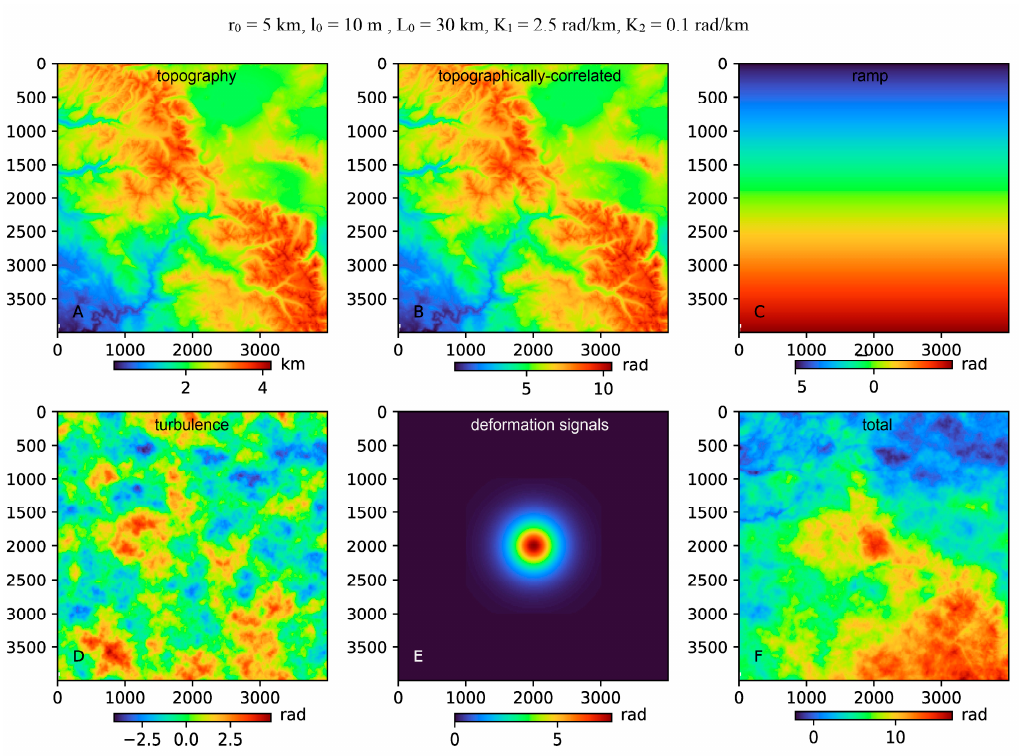
Figure 4. A schematic description of the construction of the synthetic interferometry: ( A ) Topography; ( B ) Topographically correlated tropospheric delays; ( C ) Large bilinear ramp are computed as described in the text; ( D ) Turbulent signals; ( E ) deformation signals that we project them to phase and combine them to form the ( F ) final synthetic interferogram. In this example, the Fried parameter r 0 is 5 km, the inner scale l 0 is 10 m, the outer scale L 0 is 30 km, the K 1 is 2.5 rad/km, and the ramp amplitude ( K 2 ) is 0.1